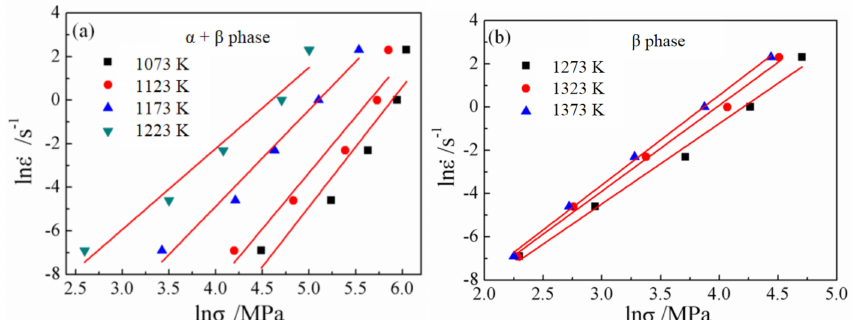
. ε and ln σ at a strain of 0.6 in different phase region. ( a ) α + β